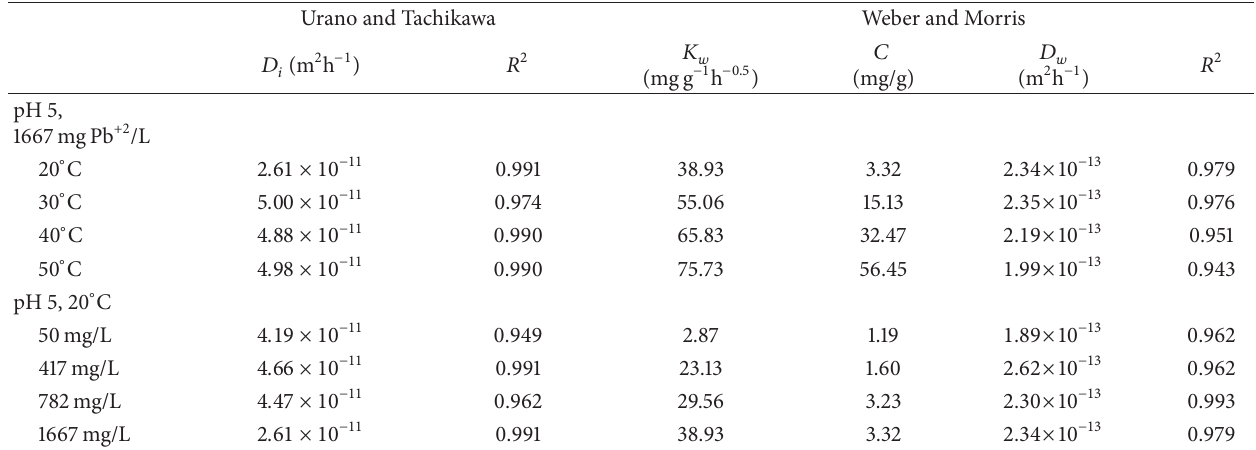
Table 6: Diffusion constants of Pb (II) at different temperatures and concentrations. Urano and